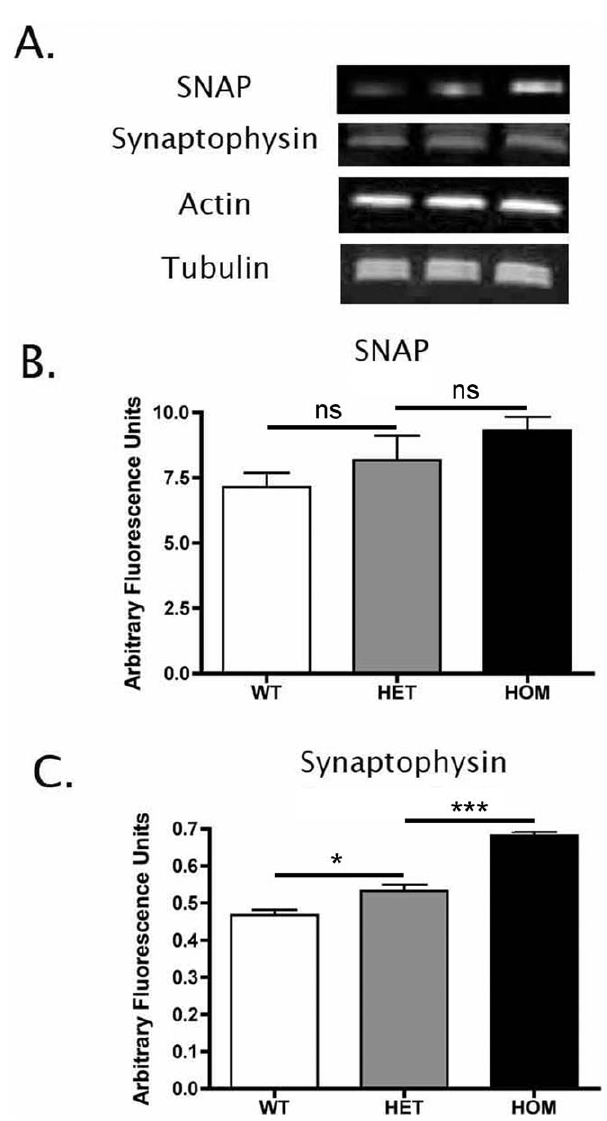
Figure 4. Quantitative western blotting for synaptic proteins confirmed dose-dependent protection of striatal synapses in Wld S mice 3 days after cortical lesion. A – Representative bands from western blots showing expression levels of two major synaptic proteins (SNAP and synaptophysin) as well as two loading controls (actin and tubulin) in the striatum of wild-type, heterozygous Wld S and homozygous Wld S mice 3 days after cortical lesion. Note lower levels of synaptic markers in heterozygous Wld S mice compared to homozygous Wld S mice and lower still levels in wild-type mice, indicative of a loss of synapses. B/C – Bar charts (mean 6 SEM) showing relative expression levels of SNAP (B) and synaptophysin (C) in the striatum of wild-type, heterozygous Wld S and homozygous Wld S mice 3 days after cortical lesion (ns=not significant, *P , 0.05, ***P , 0.001; ANOVA with Tukey’s post-hoc test; N=3 mice per genotype). Levels of actin and tubulin remained constant between samples (data not shown but see Panel A). doi:10.1371/journal.pone.0015108.g004 following cortical lesion, with heterozygous Wld S mice showing approximately half the level of protection observed in homozygous Wld S mice. In contrast, we show that increasing age had no influence on levels of synaptic protection in the brain, revealing different synaptoprotective phenotypes in the CNS and PNS of old ( . 7 mth) Wld S mice. Taken together, these findings suggest that